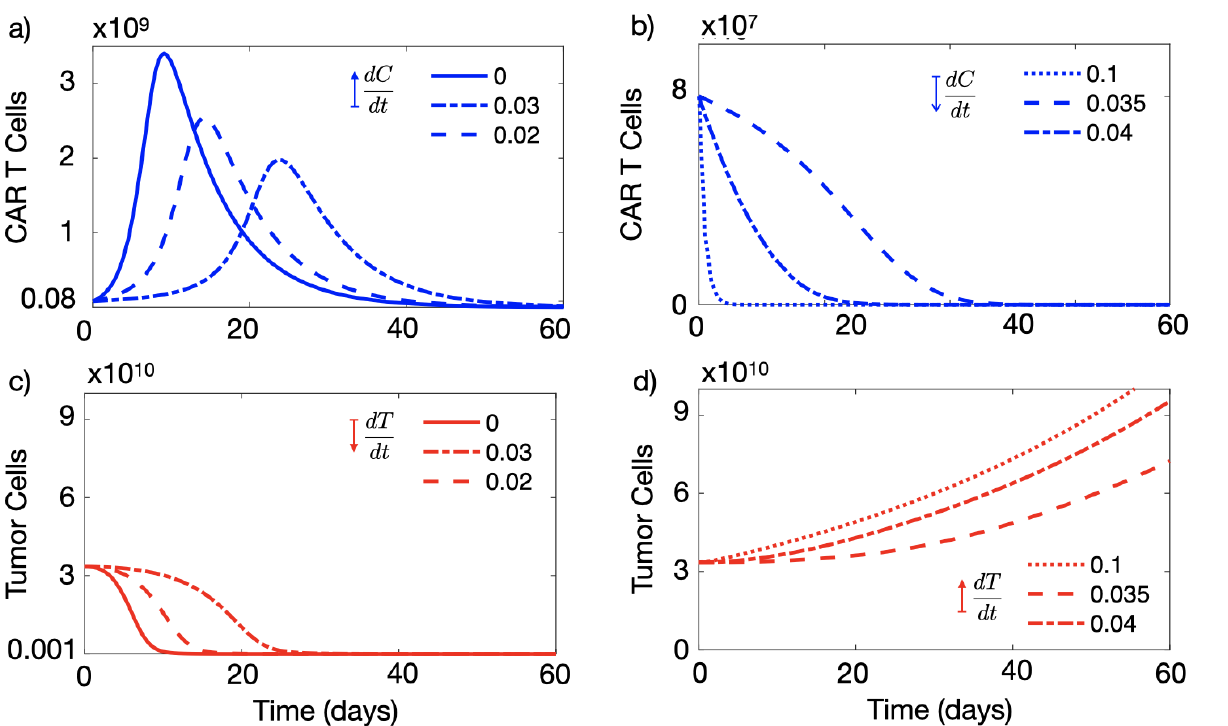
Figure 1. Tumour immune suppression governs the expansion of CAR-T cell sin silico. Dynamics of the number of CAR-T (blue curves) and tumour cells (red curves) governed by Equations (1) and (2) in different immune suppression scenarios. Subplots ( a , c ) show the results for α 1 = 0 (solid lines), α 1 = 0.02 day − 1 (dashed lines) and α 1 = 0.03 day − 1 (dash-dotted lines) and subplots ( b , d ) for α 1 = 0.035 day − 1 (dashed lines), α 1 = 0.04 day − 1 (dash-dotted lines) and α 1 = 0.1 day − 1 (dotted lines). Initial data used in the simulations C 0 = 8 × 10 7 cells, T 0 = 3.35 × 10 10 cells and parameter